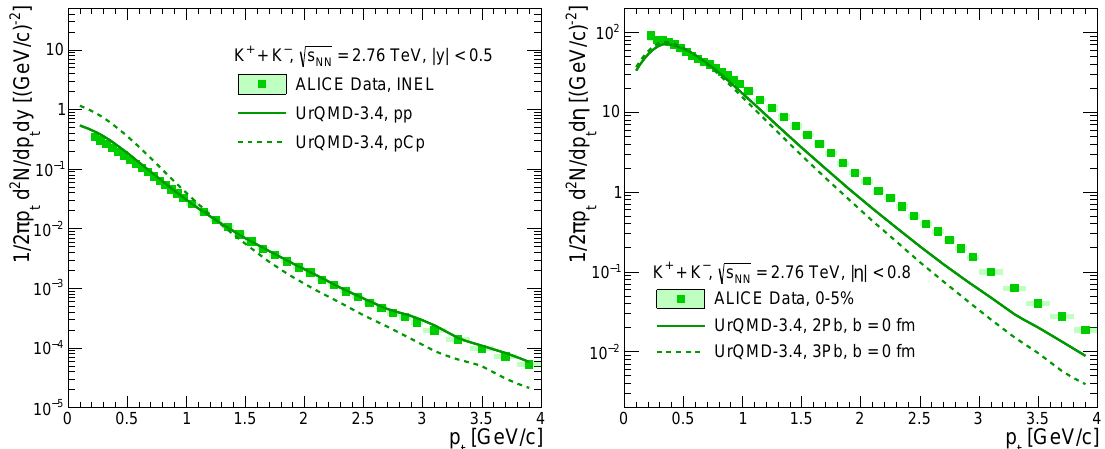
Figure 3. Comparison of the pseudorapidity distributions of charged particles dN ch experiments with the ones obtained by the UrQMD simulations. ( Left panel: ) ALICE data on inelastic p+p collisions of Ref. [40] measured at minimum bias at results (solid curve). For comparison, the dashed curve shows the same distribution for the p+C+p TNC. ( Right panel: ) ALICE data of Ref. [16] measured in 0–5% most central Pb+Pb collisions at √ s NN = 2.76 TeV (symbols) vs. the UrQMD results (solid curve). The dashed curve shows the same distribution for the Pb+Pb+Pb TNC.